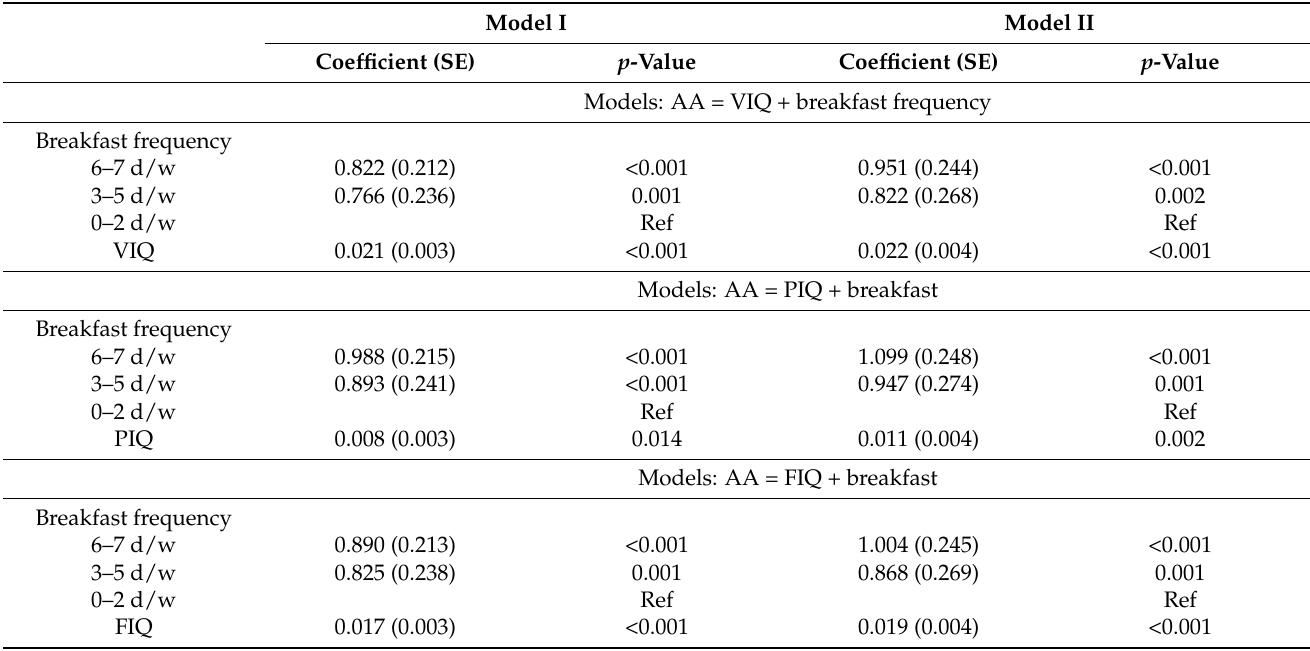
Figure 2. Effect of breakfast food types and consumption frequency on IQ scores/academic achievement. Note : The Y-axis denotes estimated marginal means (least square means) of IQ scores and academic achievement using multivariable GLM models. Table 6. Effect of IQ scores and breakfast consumption frequency on academic achievement in the 2nd wave ( n =